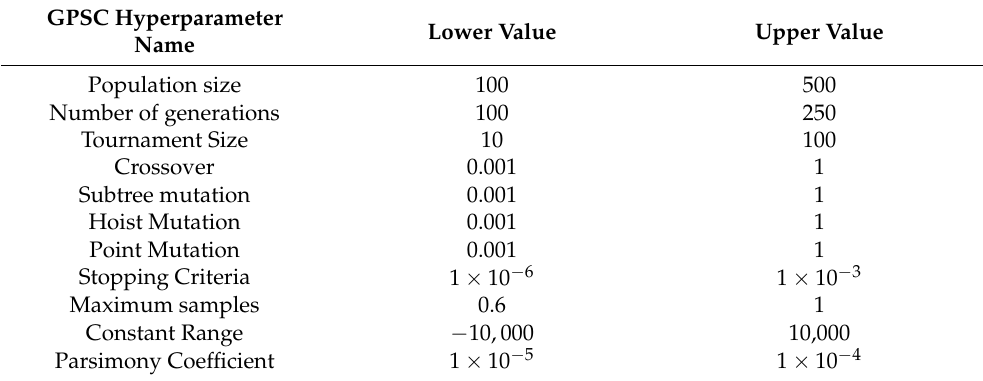
Table 2. The list of predefined ranges of GPSC hyperparameters used in random hyperparameter search